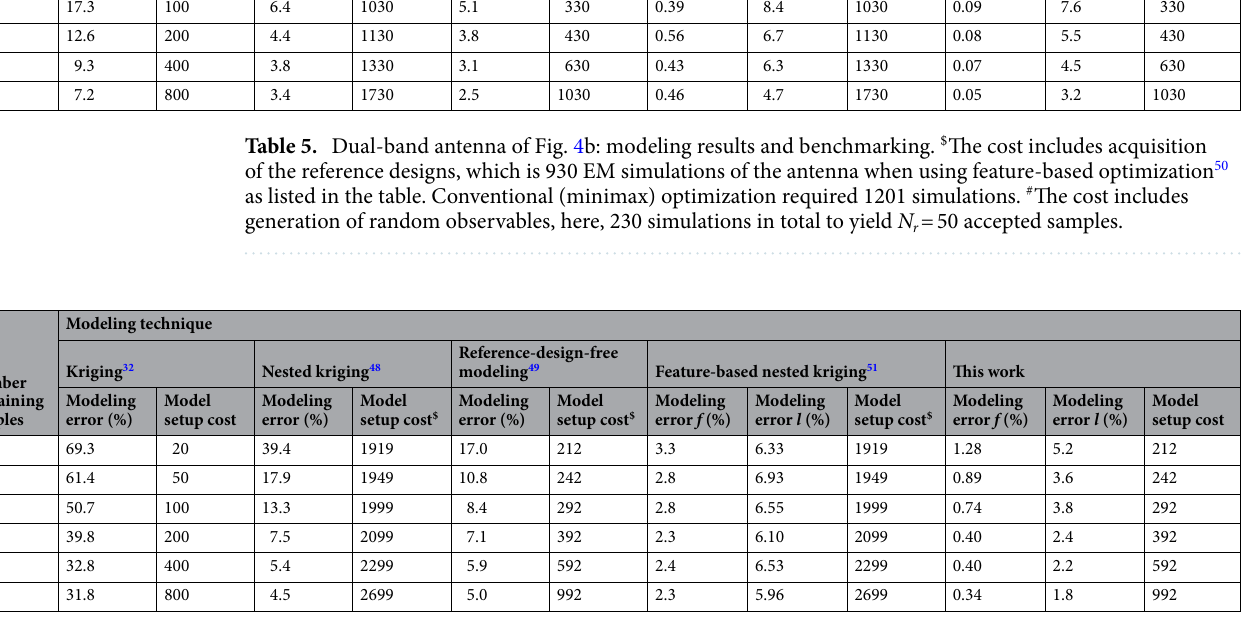
Table 6. Quasi-Yagi antenna of Fig. 4c: modeling results and benchmarking. $ The cost includes acquisition of the reference designs, which is 1899 EM simulations of the antenna when using feature-based optimization 50 as listed in the table. # The cost includes generation of random observables, here, 192 simulations in total to yield N r = 50 accepted